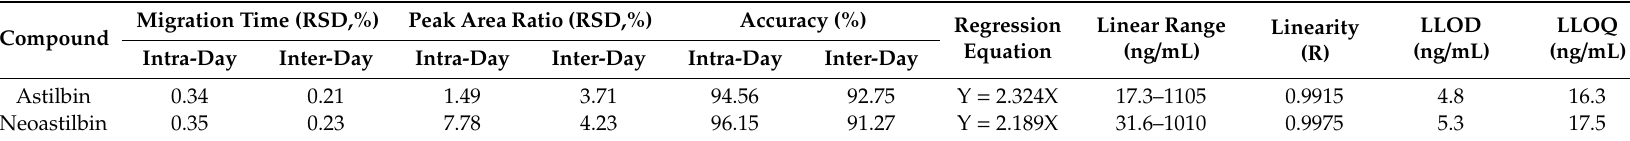
Table 2. The accuracy, precision (Relative standard deviation, RSD), linearity, lower limit of detection (LLOD), and lower limit of quantitation (LLOQ) of astilbin and neoastilbin in rat plasma (~100 ng / mL). (n =